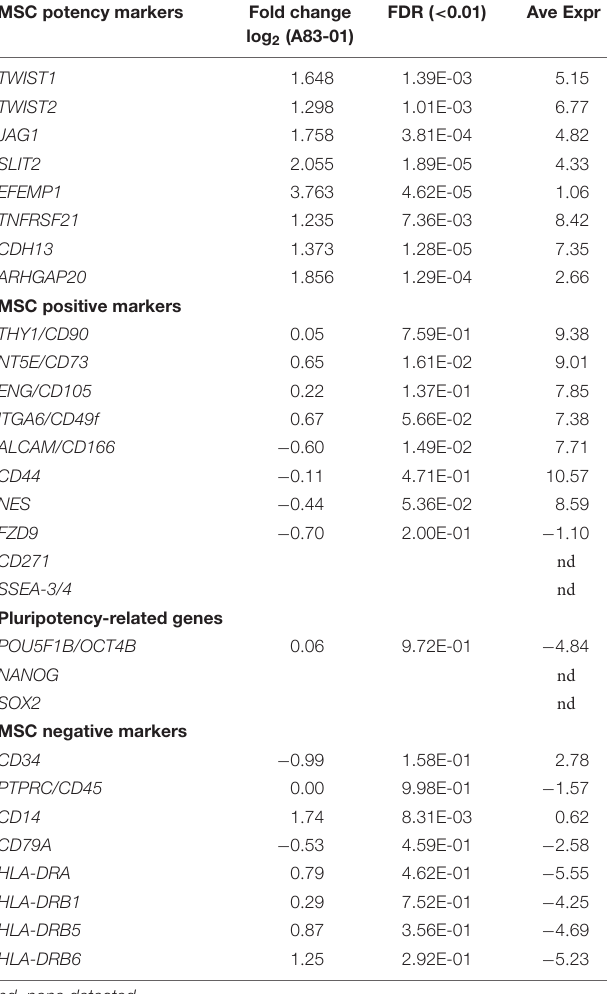
TABLE 2 | Gene profile of MSC potency in A83-01-treated versus control eMSCs. MSC potency markers Fold change FDR ( < 0.01) log 2 (A83-01)